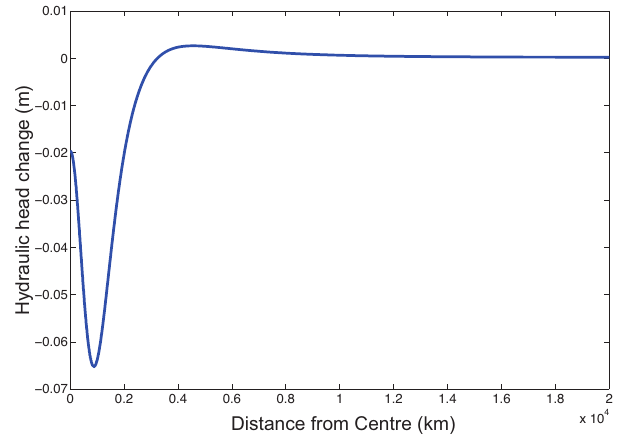
Figure B1. Hydraulic head change profile in the pyroclastic aquifer for z CH = 1km.